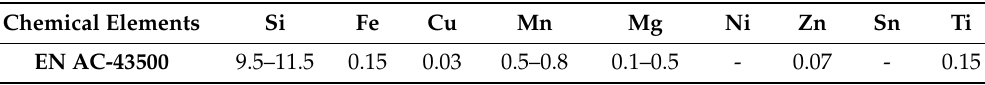
Table 1. Chemical composition of EN AC-43500 aluminum alloy .